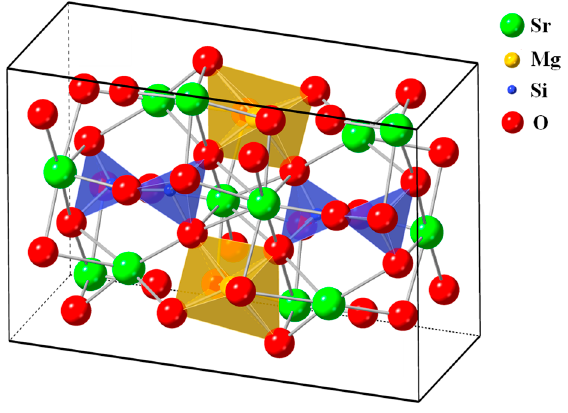
Figure 2. Crystal structure of the [Sr 0.99 Eu 0.01 ] 3 MgSi 2 O 8 phosphors.